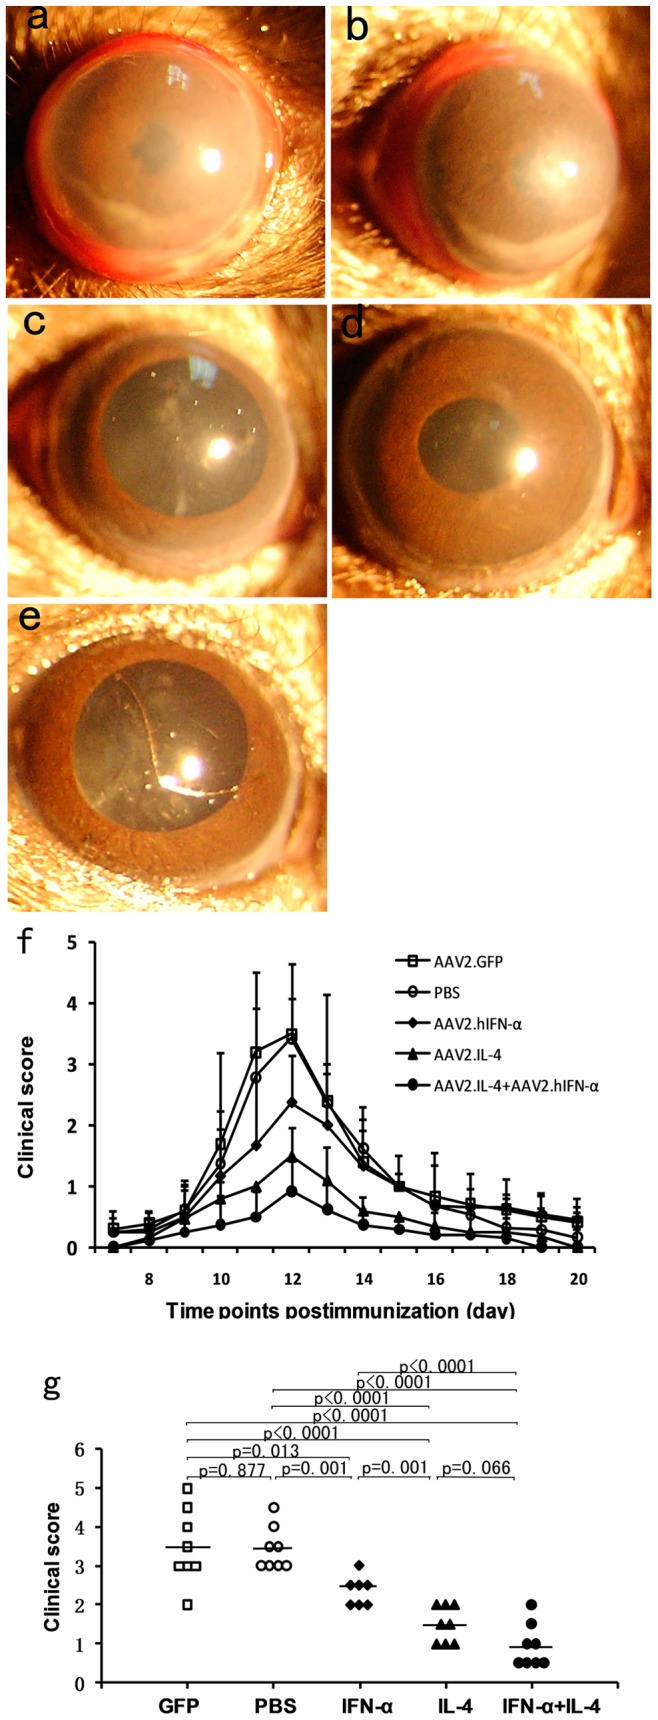
Clinical evaluation of EAU activity.EAU was induced in groups of mice receiving subretinal vector or PBS injection. Severe uveitis is observed in the PBS (a) and AAV2.GFP injected eyes (b) as compared to the AAV vectors treated eyes (c–e). Three AAV vector treated groups show significantly attenuated EAU over time as compared with controls (f). Data are presented as mean±standard deviation. The clinical score shows that compared with controls, the AAV2.IFN-α treated group (p = 0.019, Mann-Whitney U test), the AAV2.IL-4 treated group (p<0.0001) and the combined treated group (p<0.0001) developed a significantly reduced EAU (g). Each point represents an individual eye. The average scores of each group are denoted by the horizontal bars.